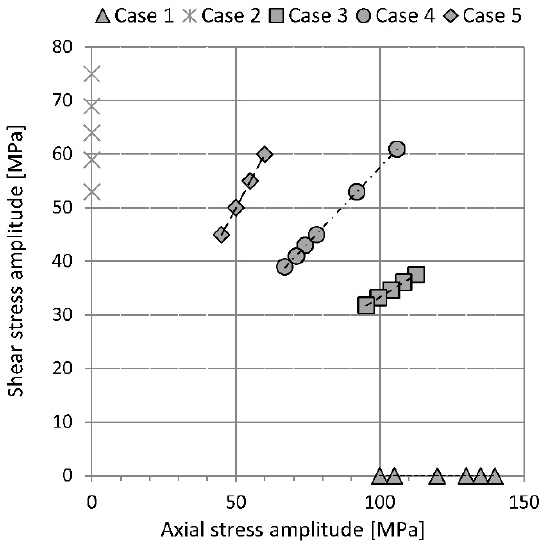
Figure 3. Normal and shear stress amplitudes with R = −1 used in experiments.